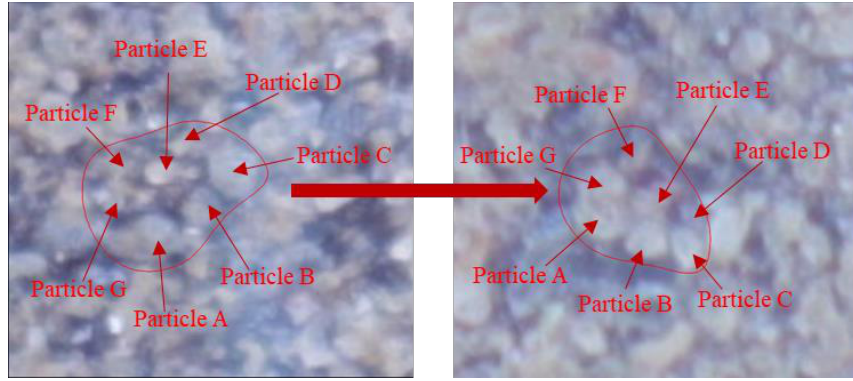
Figure 13. Overall movement of a block.